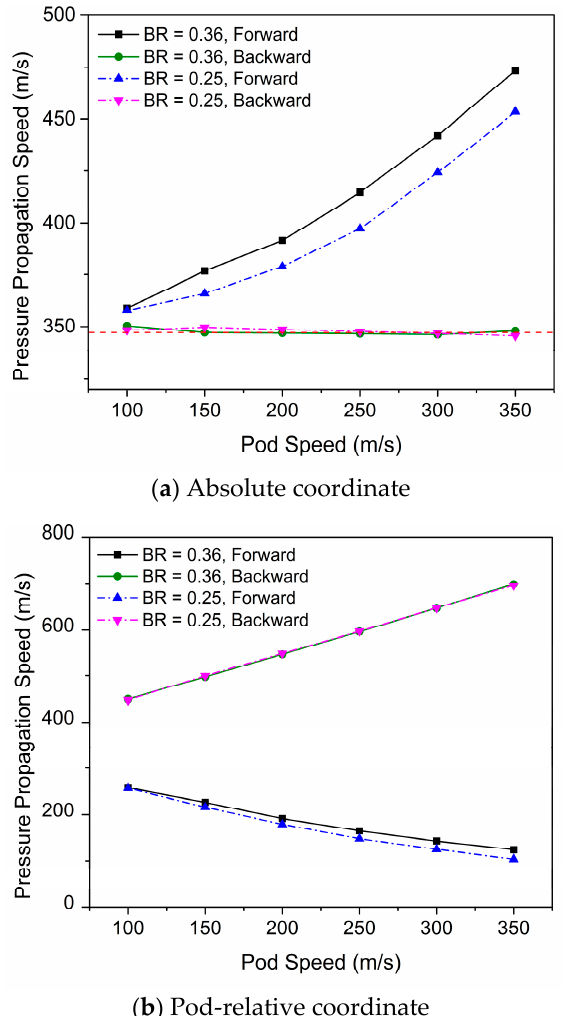
Figure 12. Forward and backward pressure wave propagation speeds observed in ( a ) absolute coordinates (the reference frame is fixed) and ( b ) pod-relative coordinates (the reference frame moves with the pod). The red dashed line represents the speed of sound (347.1 m/s).